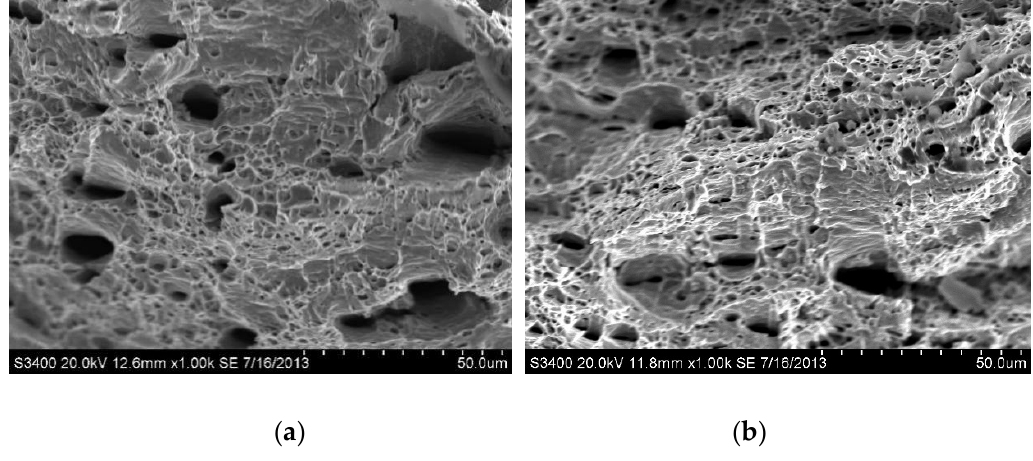
Figure 6. SEM fractographs of as-received AISI 430 steel ( a ) without hydrogen pre-charging; and ( b ) with hydrogen pre-charging.